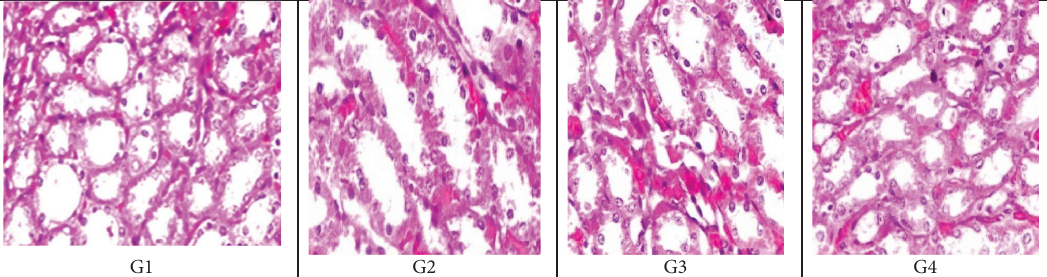
Figure 6: H&E stain showing the histological structure of kidney tissue section at 20x magnifcation in the form of (G1) negative control group, (G2) rats infected with MRSA without treatment, (G3) rats treated with antibiotics, and (G4) rats treated with A. herb Alba TiO2 NPs.